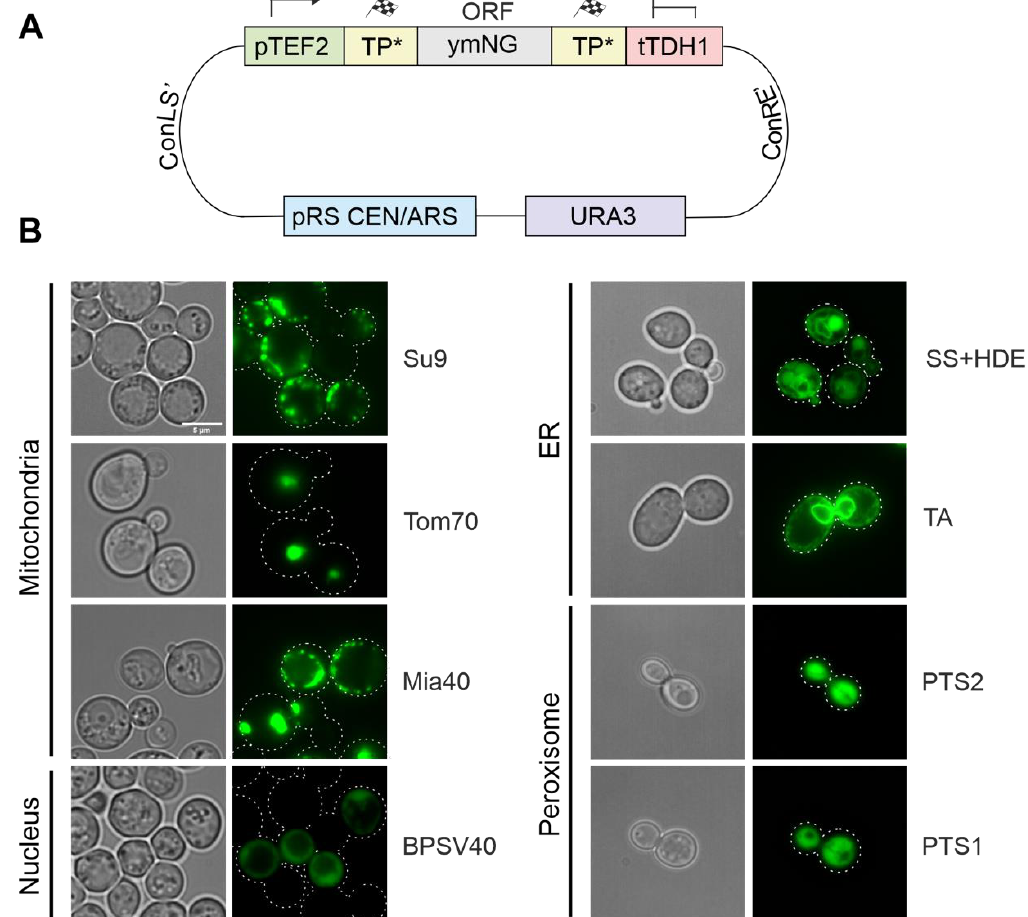
FIGURE 3: Targeting sequences direct GFP to different intracellular localizations. (A) Schematic overview of the general construction of expression plasmids using the MoClo approach. (B) Brightfield and fluorescence images of strains expressing NeonGreen fused to the target- ing sequences indicated. Cells were grown in synthetic glucose media (SD-Ura) until mid-log phase, harvested and resuspended in PBS for imaging. TA, tail-anchor of Ubc6 for ER-targeting. Pictures were taken with a Leica Dmi8 Thunder Imager. All fluorescence pictures were taken as Z-stacks. Pictures were edited using ImageJ and CorelDraw. Scale bar, 5